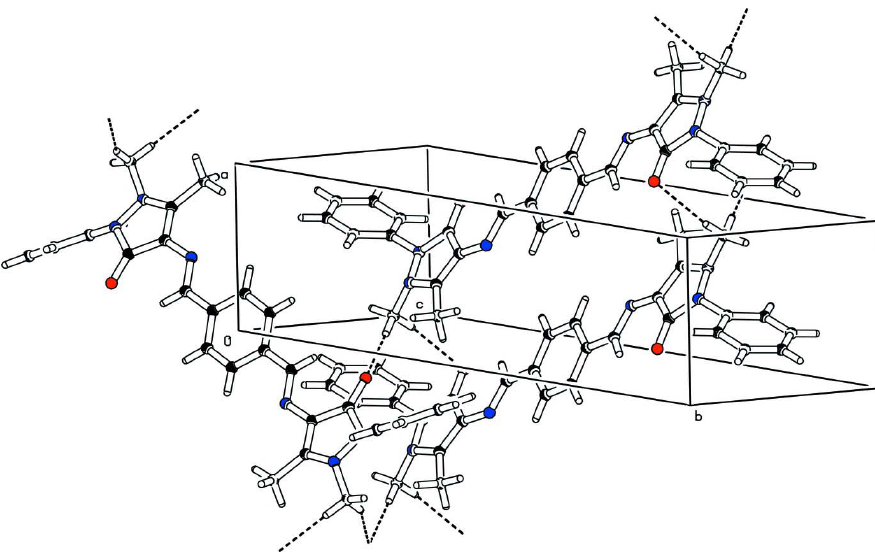
Figure 2 A packing diagram for (I). Hydrogen bonds are shown as dashed